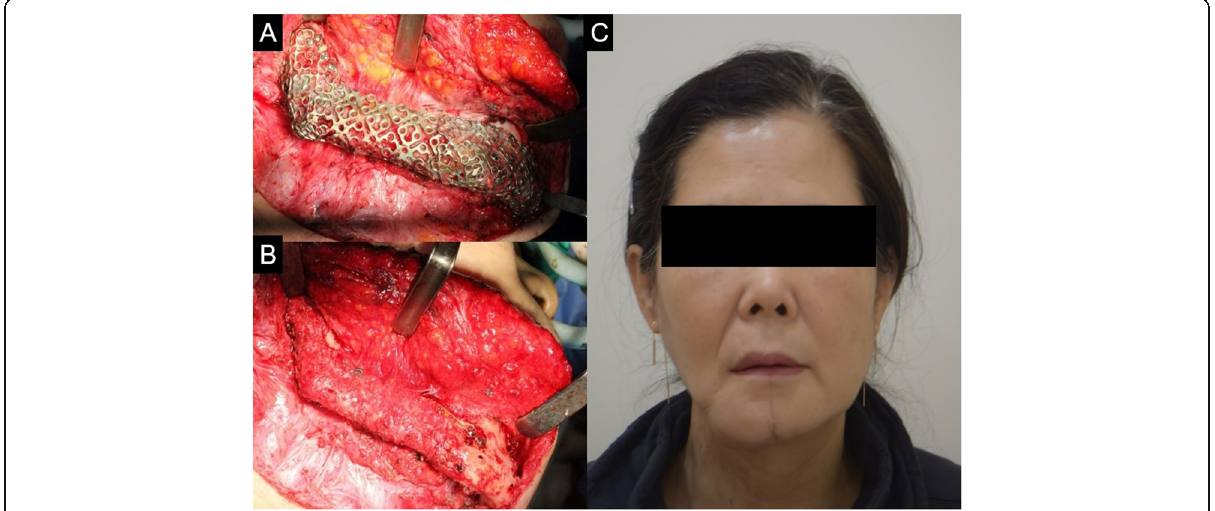
Fig. 8 a , b Neomandible state before and after T-mesh removal. c The patient ’ s frontal view with